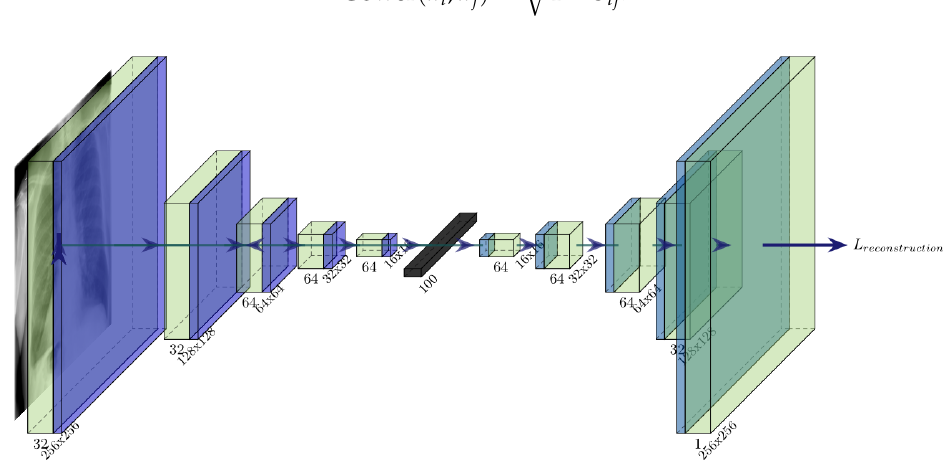
Figure 3. Architecture of the proposed convolutional autoencoder, which is later fine-tuned using pairwise